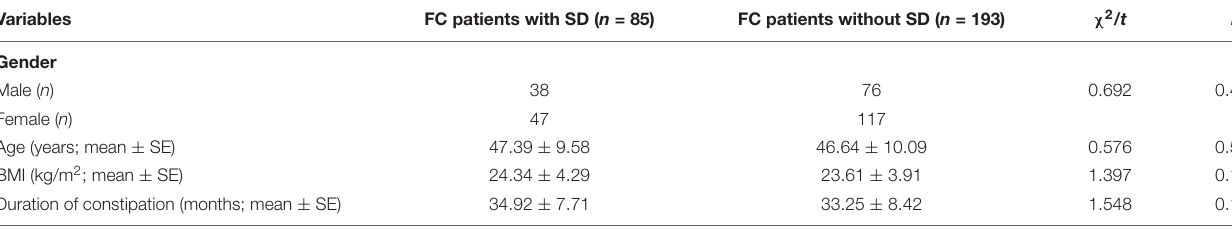
TABLE 1 | Characteristics of the FC population ( N = 278). Variables FC patients with SD ( n = 85)